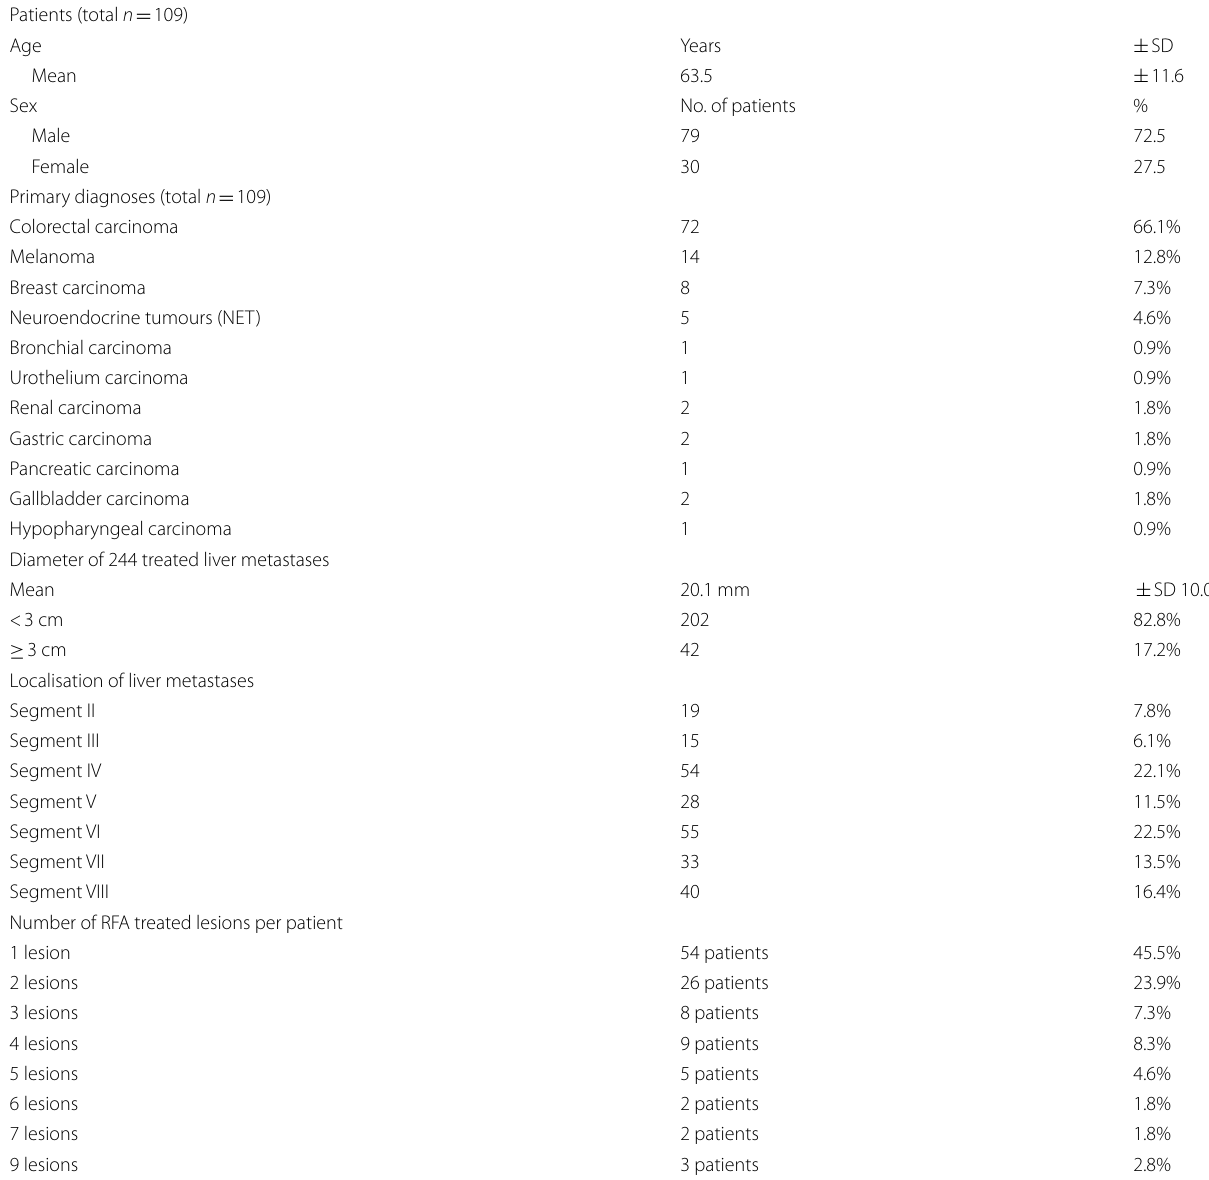
Table 2 Cohort characteristics of patients treated with RFA Patients (total n =